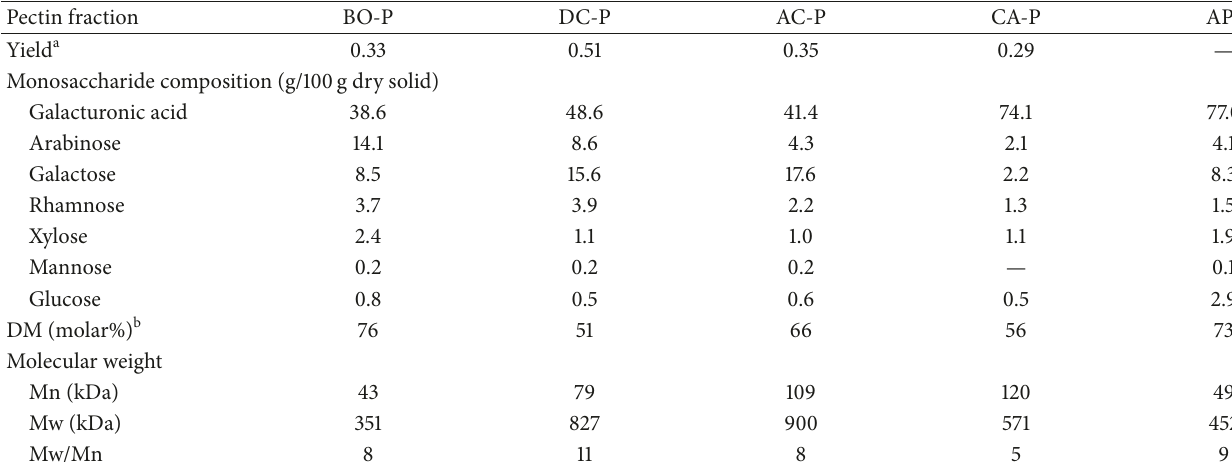
Table 1: Yield and chemical properties of the pectin fractions